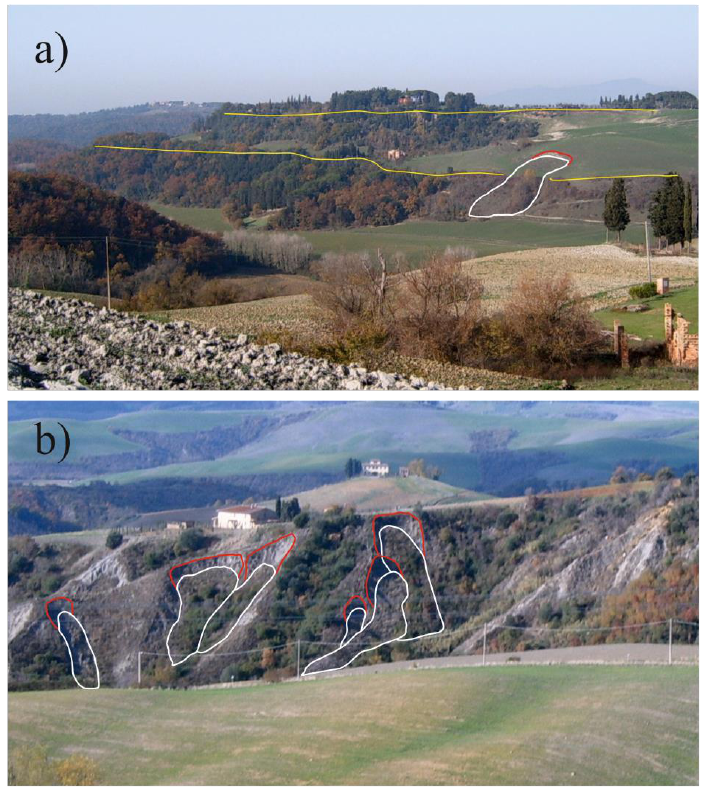
Figure 2. Field photographs. ( a ) The “ balze ” morphologies in the Roglio basin and the gravity evolution. The yellow line represents the degradation scarp of the “ balze ”, whereas the black and white lines represent the main scarp upper edge and the body of an actual rotational slide, respectively. ( b ) The badlands in the Roglio basin and the gravity evolution connected with the development of the landslides. The black and white lines represent, respectively, the main scarp upper edges and the bodies of recent translational slides.